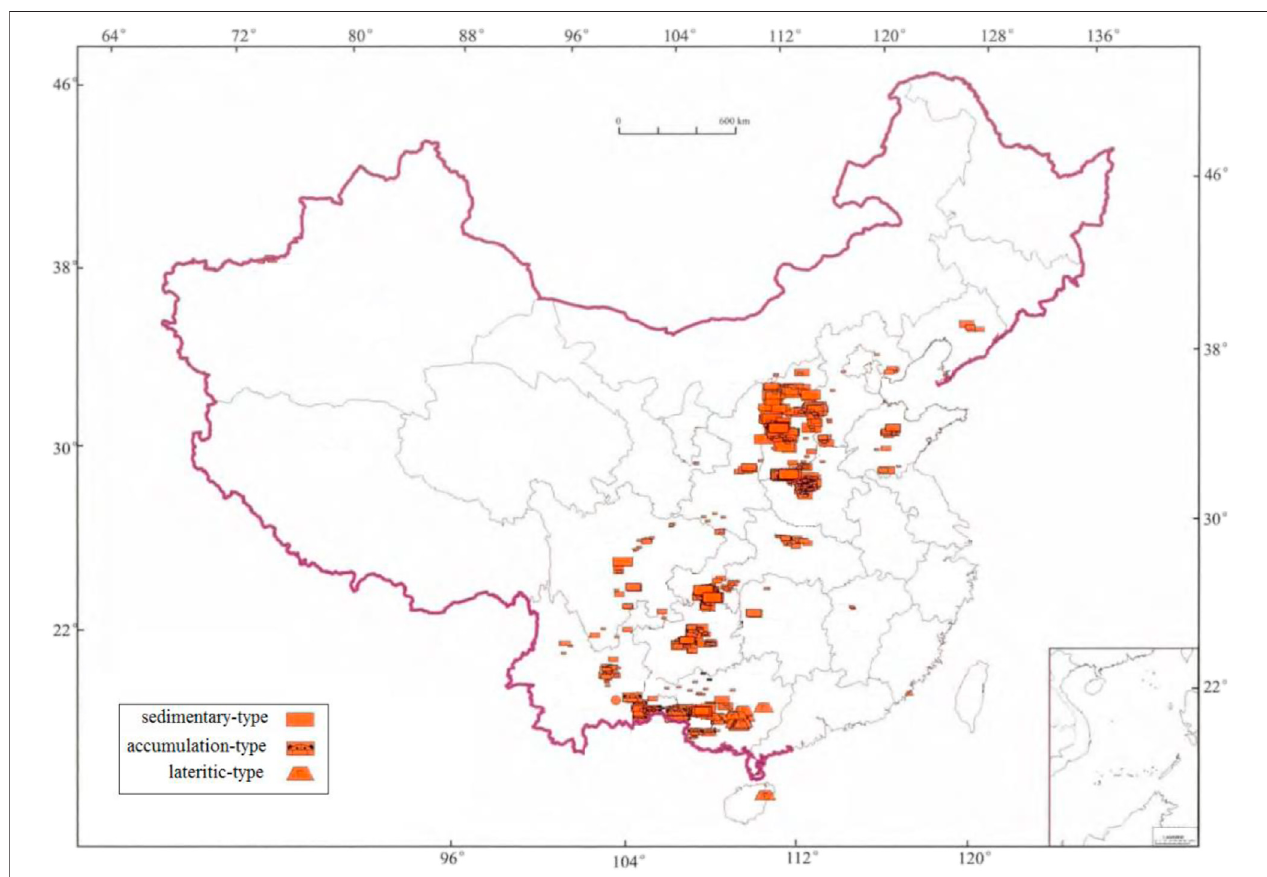
FIGURE 1 | Distribution of bauxite deposits in China (modi fi ed after Gao et al., 2014).